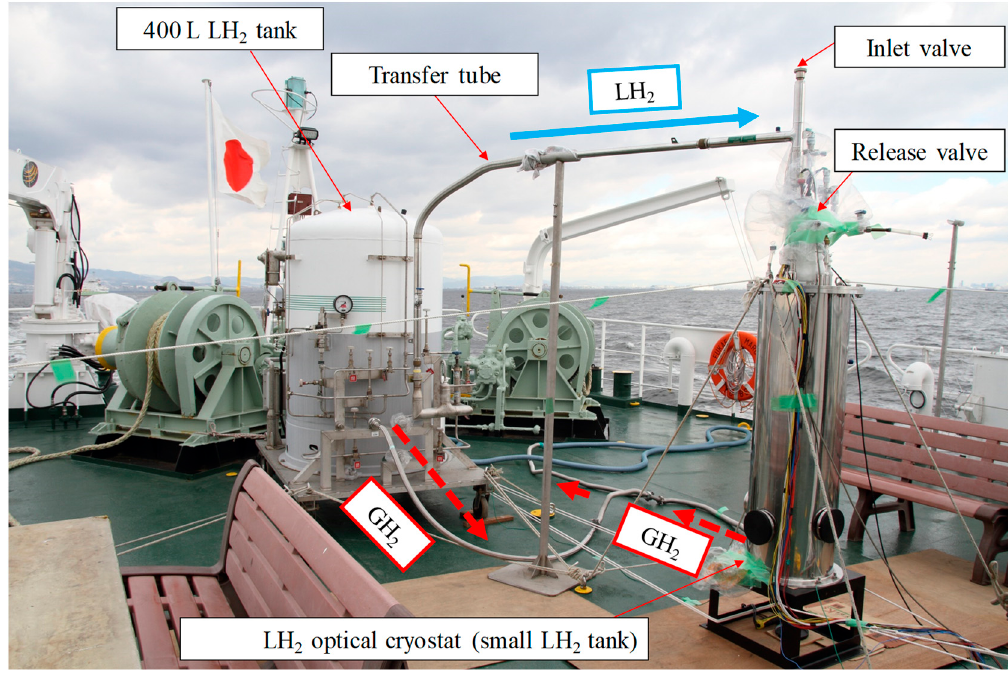
Figure 6. Photograph of the experimental setup on the afterdeck.